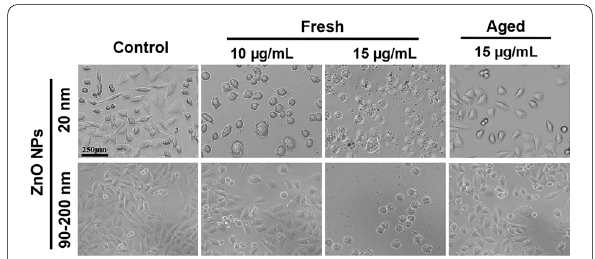
Fig. 2 Morphology changes in A L cells after exposure to fresh or aged ZnO NPs for 72 h in supplemental Ham’s F12 medium, and unexposed cells were used as control groups. A L cell morphology was observed with an optical microscope at 10 ×